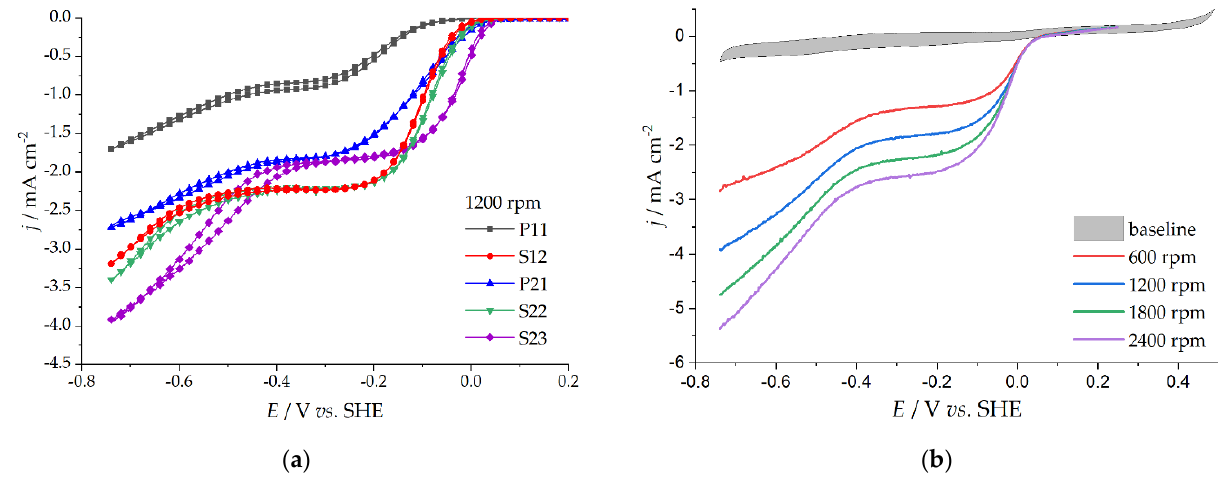
Figure 6. The results of the analysis of the ORR activity of studied samples in O 2 -saturated 0.1 mol dm − 3 KOH solution: ( a ) background-corrected RDE-CV curves at a common electrode rotation rate of 1200 rpm for all the samples (potential scan rate 20 mV s −1 ); ( b ) RDE-LSV curves of the S23 sample at different electrode rotation rates. Table 8. Kinetic parameters for ORR for the studied samples: onset potential ( E onset ), number of electrons ( n ) consumed per O 2 molecule, and kinetic currents ( j k ).